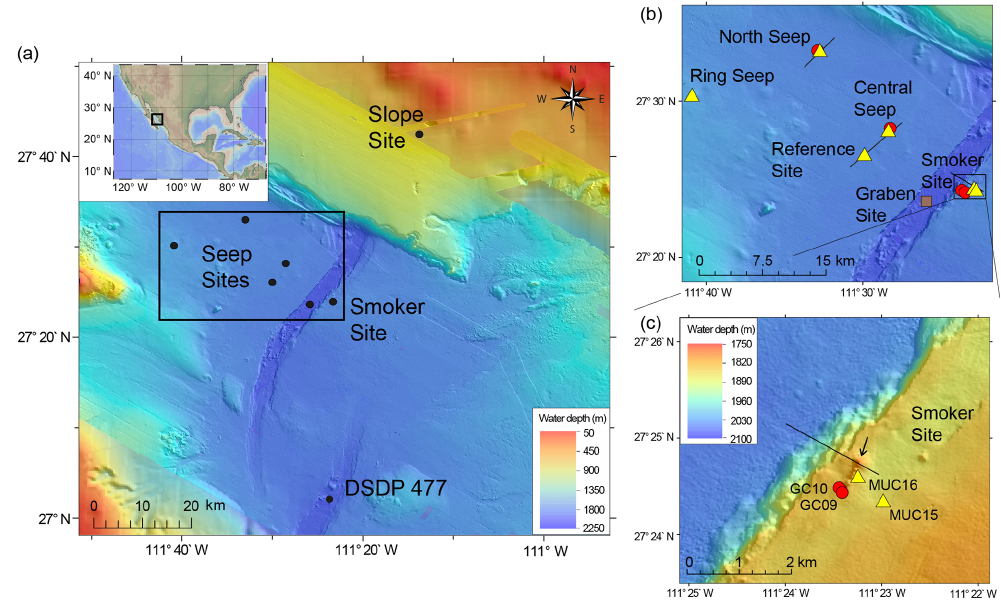
Figure 1. Sample locations in the Guaymas Basin, Gulf of California studied during RV SONNE expedition SO241. (a) Overview of stations (Seep sites, Smoker Site, and Slope Site). Black square indicates enlarged area in (b) . Site DSDP 477 in the southern trough is shown for comparison. (b) Enlargement of the sampling locations. Red circles refer to GC employments and yellow triangles to MUCs. Brown square at Graben Site refers to water-column sampling and temperature measurements. Black lines refer to seismic profiles displayed in Fig. 2. (c) Enlargement of the Smoker Site sampling locations. Note the different scale compared to (a) and (b) . Black arrow refers to the location of the hydrothermal mound described in Berndt et al.